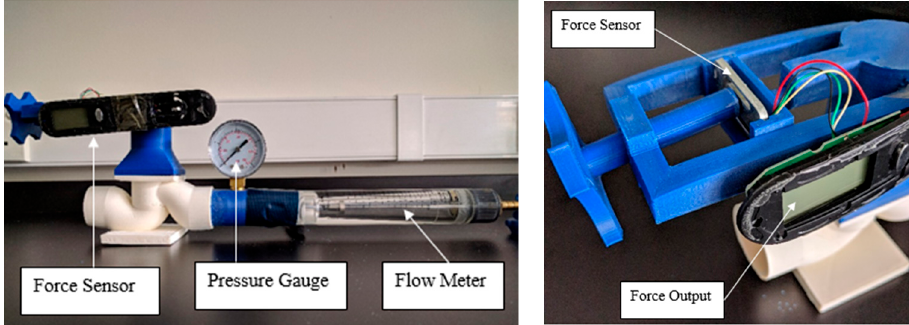
Figure 7. Experimental analysis setup.